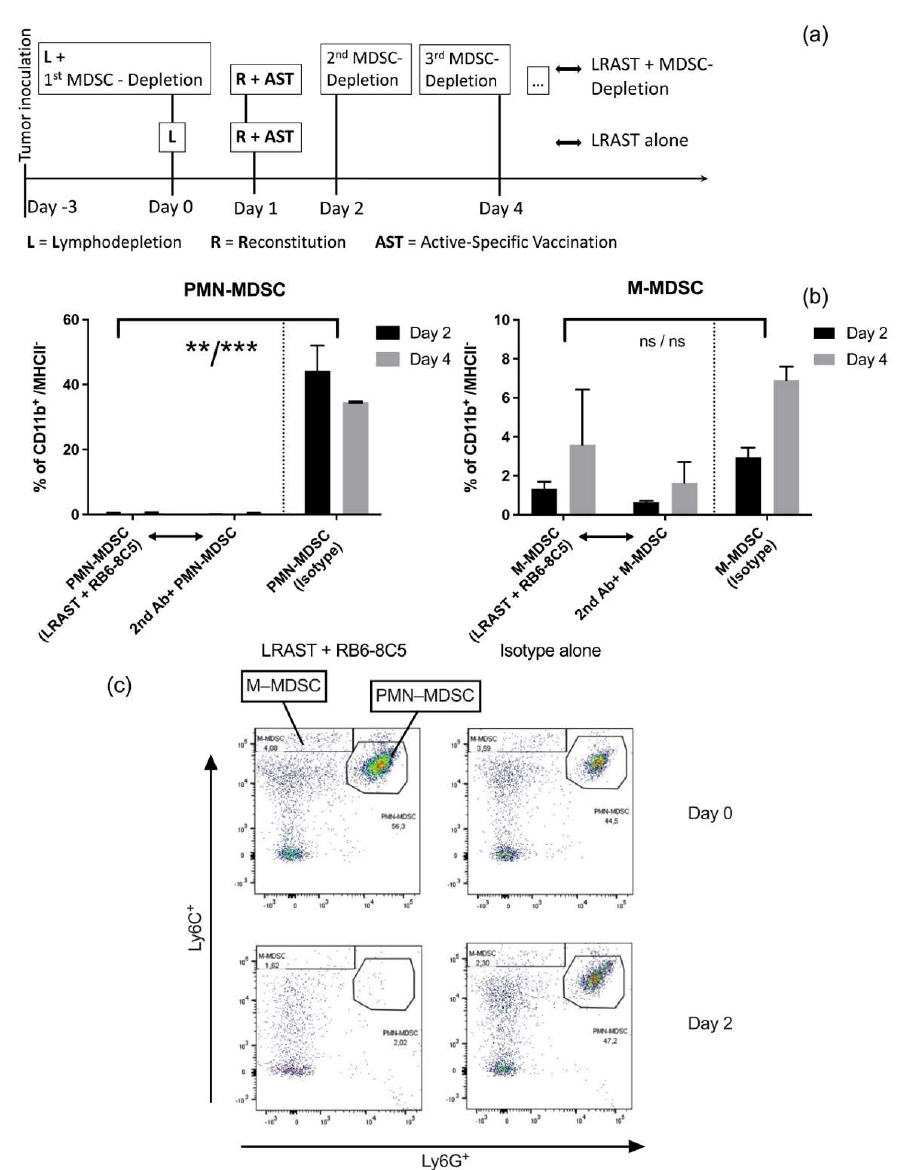
Figure 2. Successful elimination of PMN–MDSC in the initial treatment phase of LRAST + RB6- 8C5 . ( a ) LRAST treatment scheme. D5 tumor cells (5 × 10 4 ) were injected s.c. into C57BL6 mice 3 days